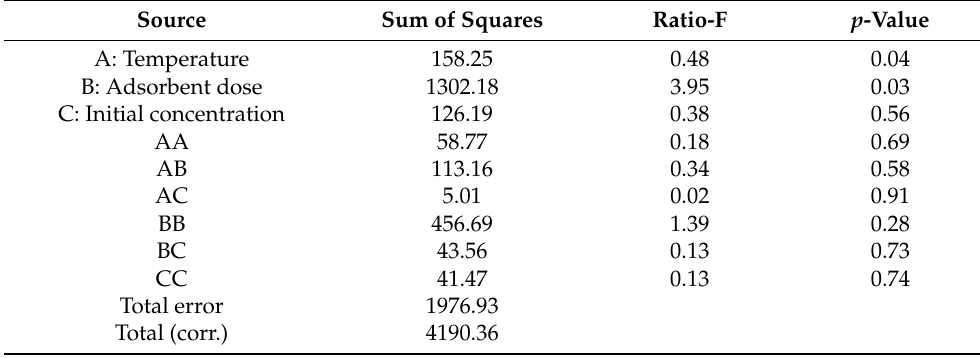
Figure 5. Main effect plot of the initial concentration on the adsorption capacity of Cr (VI). Table 5. Analysis of variance of Cr (VI)